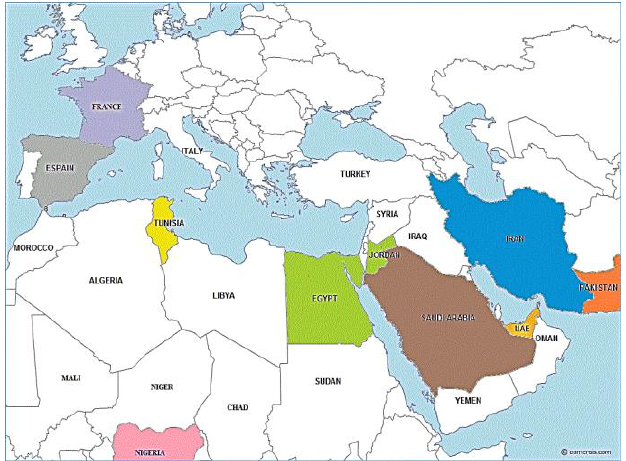
Figure 8: The paleogeographic distribution of the Orthokarstenia members in some countries in the Northern Tethys (Spain and France) and many countries in the Southern Tethys (Nigeria, Tunisia, Egypt, Jordan, Saudi Arabia, United Arab Emirates, Iran and